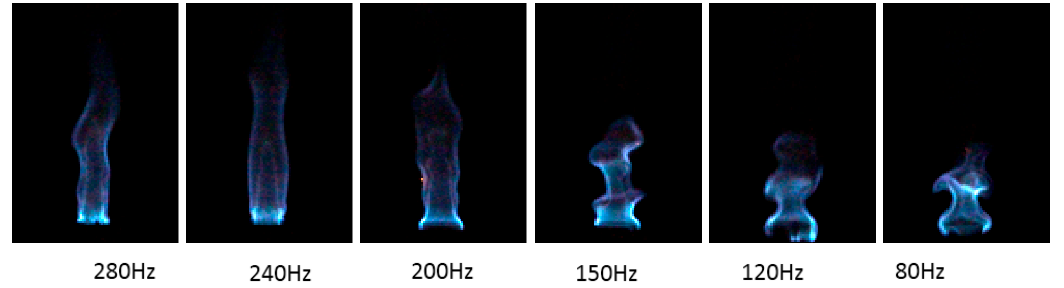
Figure 6. Flame surface wrinkling under different frequencies (345 ± 10Pa).